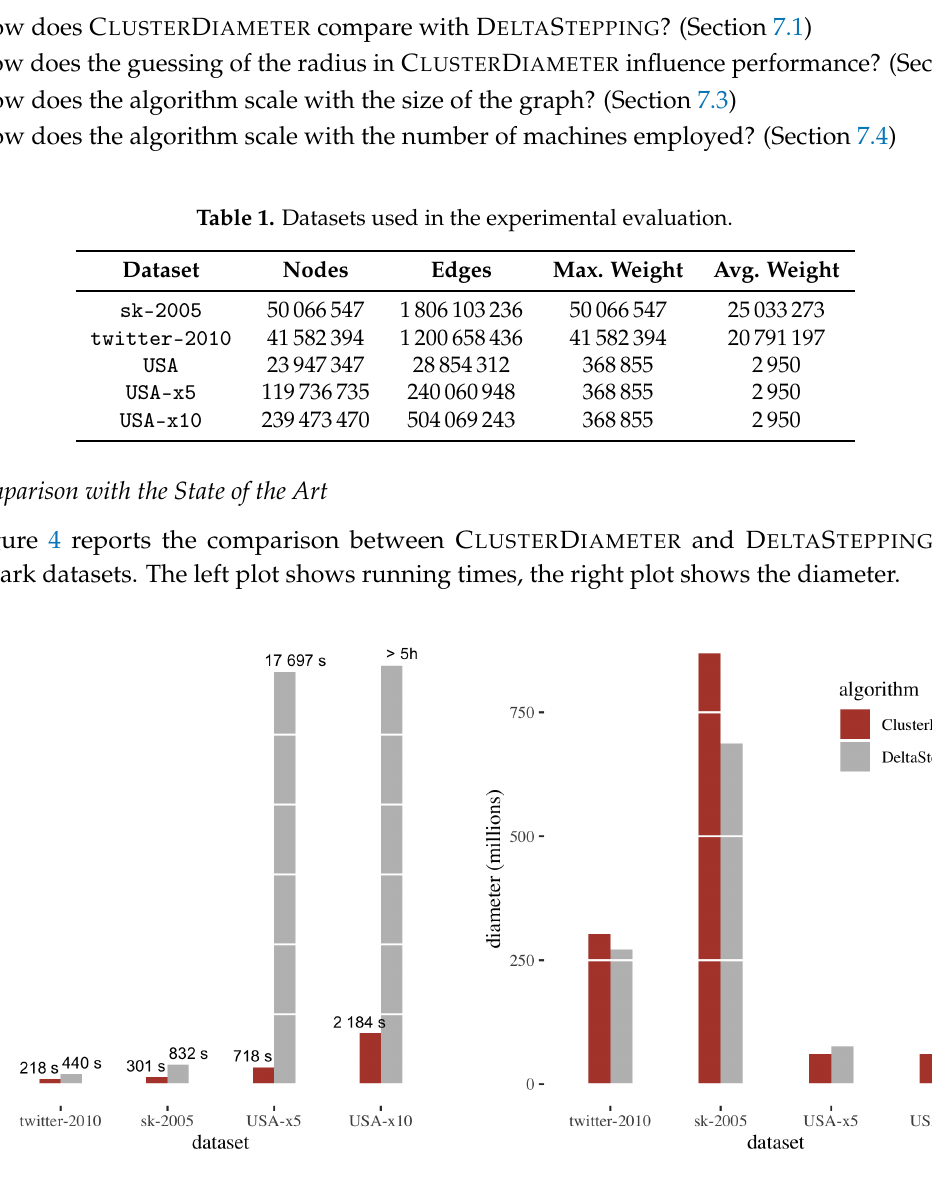
Figure 4. Comparison between D ELTA S TEPPING and C LUSTER D IAMETER : running time ( left ) and diameter ( right ). On USA-x10 D ELTA S TEPPING timed out after five